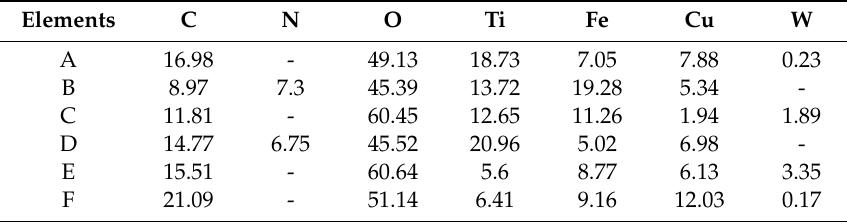
Table 5. Semi-quantitative EDS results for the points A–F in Figure 14 (at.%).